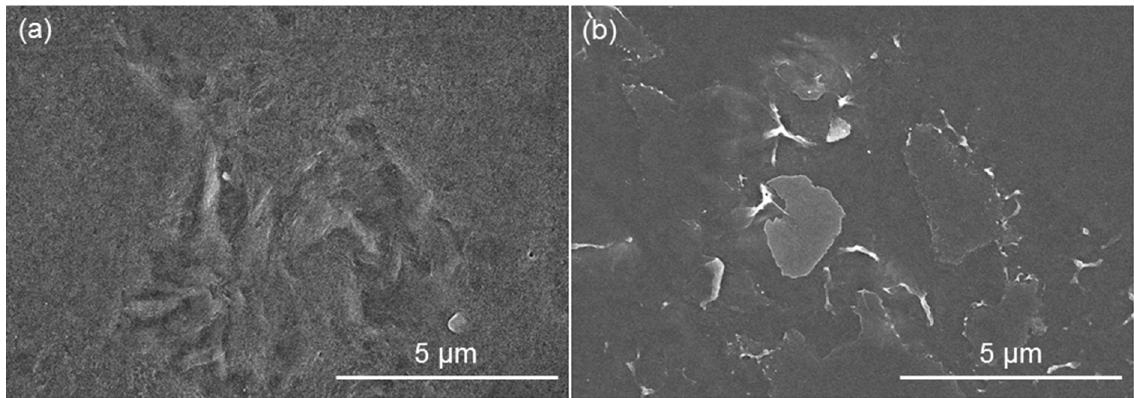
Figure 2. SEM image of ( a ) PVDF and ( b ) NPVDF fi lms.